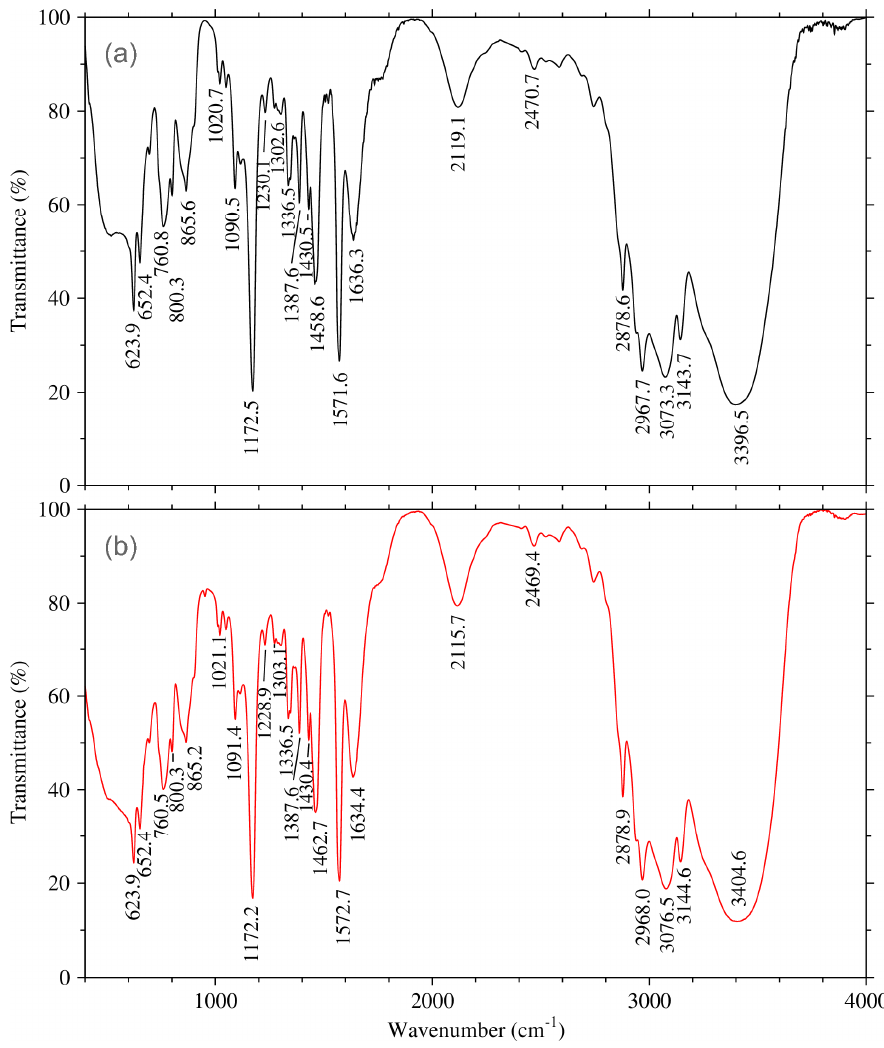
Figure 1. FT-IR spectra of ( a ) [PrMIm]Cl and ( b ) the catalyst CuCl 2 -[PrMIm]Cl.